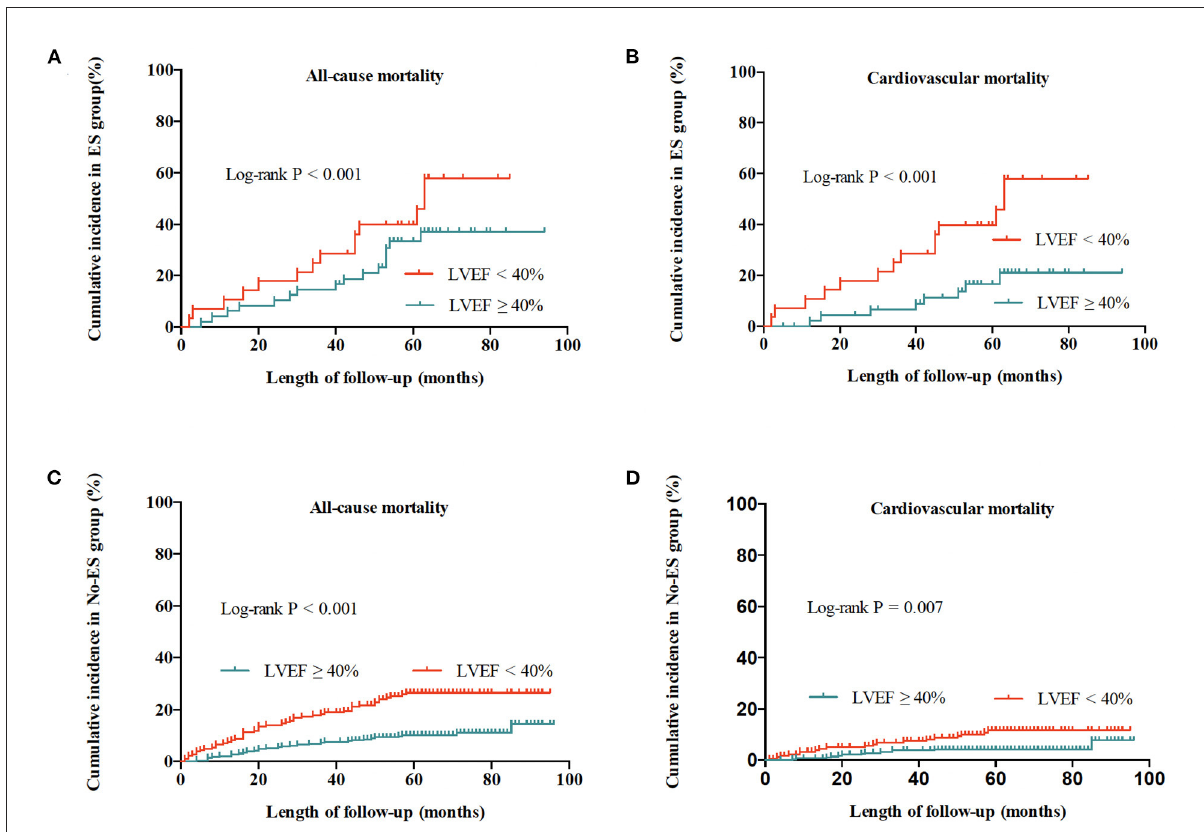
FIGURE4 Cumulative incidences of all-cause and cardiovascular mortality for patients with ES and without ES. (A) All-cause mortality for patients with ES. (B) Cardiovascular mortality for patients with ES. (C) All-cause mortality for patients without ES. (D) Cardiovascular mortality for patients without